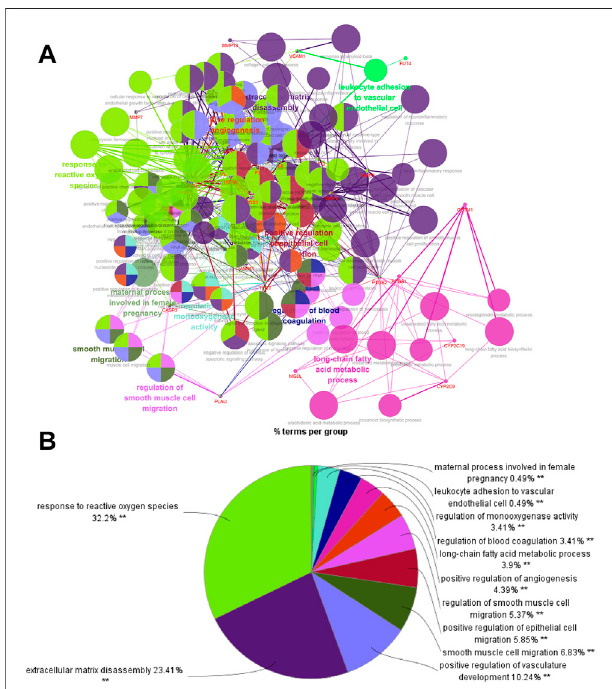
FIGURE 7 | Biological process of GO enrichment analysis (from ClueGO).